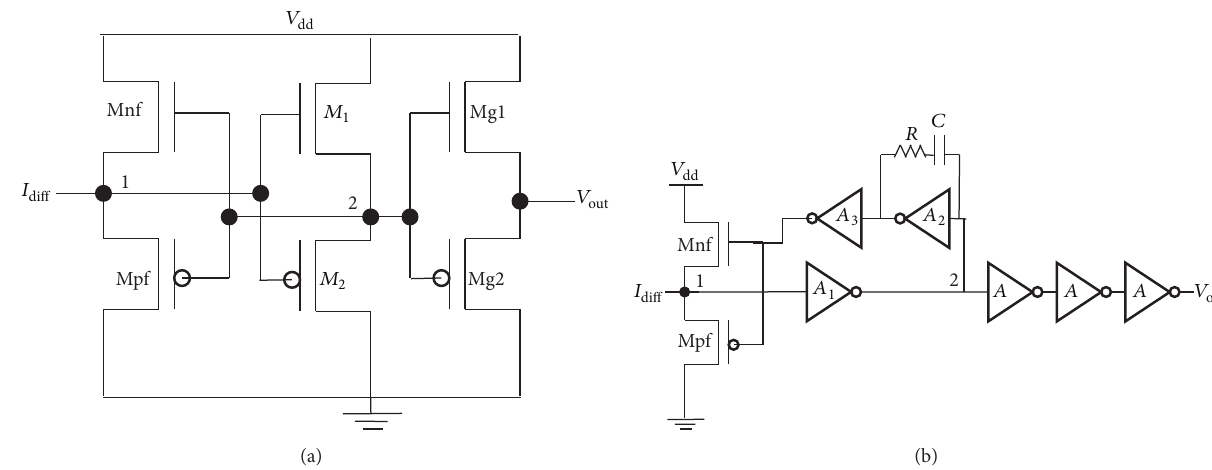
Figure 1: (a) Traff’s [9] current comparator; (b) Tang and Pun’s [10] current